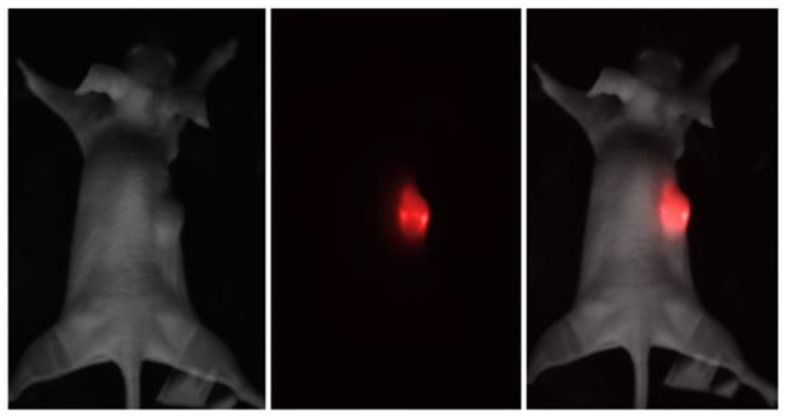
Brightfield, epiluminescent, and overlay images of the immunodeficient mouse, bearing a grafted subcutaneous A375 tumor. The UCNP luminescence at 800 nm is represented in red color.